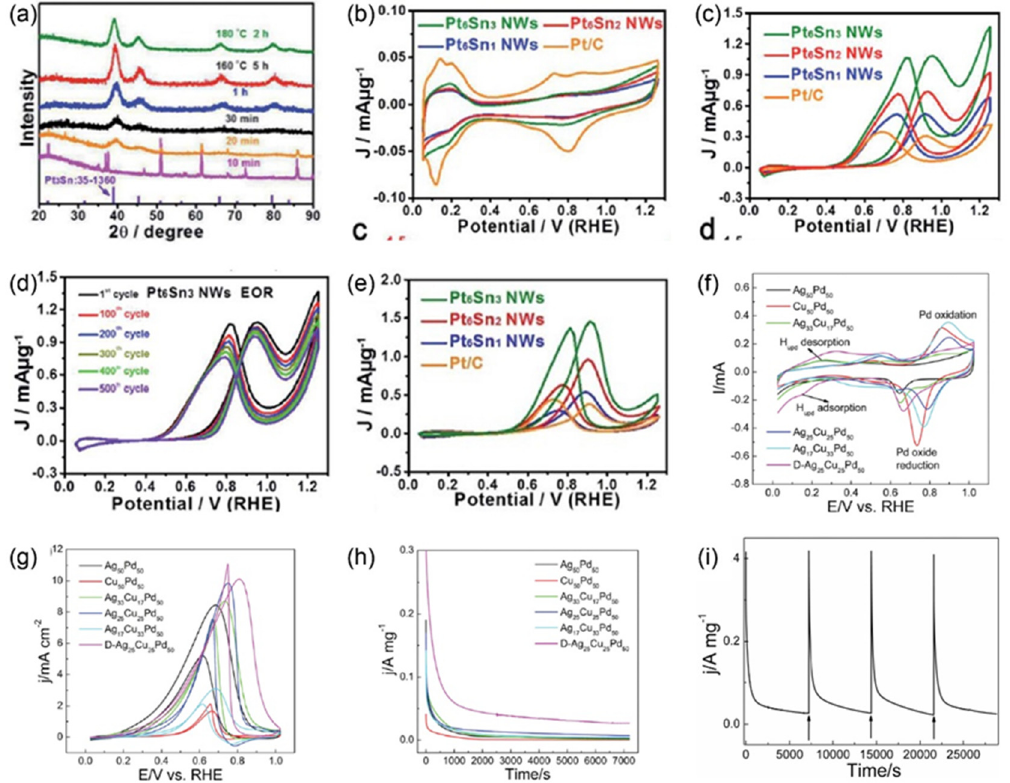
Figure 4. ( a ) Powder x-ray diffraction (PXRD) patterns of the networked Pt 6 Sn 3 NWs at different times and temperatures. cyclic voltammetry (CV) curves of different catalysts in ( b ) 0.1 M HClO 4 and ( c ) in 0.1 M HClO 4 + 0.5 M C 2 H 5 OH solution with a sweep rate of 50 mV s − 1 . ( d ) CV curves of the networked Pt 6 Sn 3 nanowires (NWs) for the EOR over 500 cycles. ( e ) CV curves in a mixture of 0.1 M HClO 4 + 0.5 M CH 3 OH [65]. Copyright (2017) Royal Society of Chemistry. ( f ) CV curves obtained